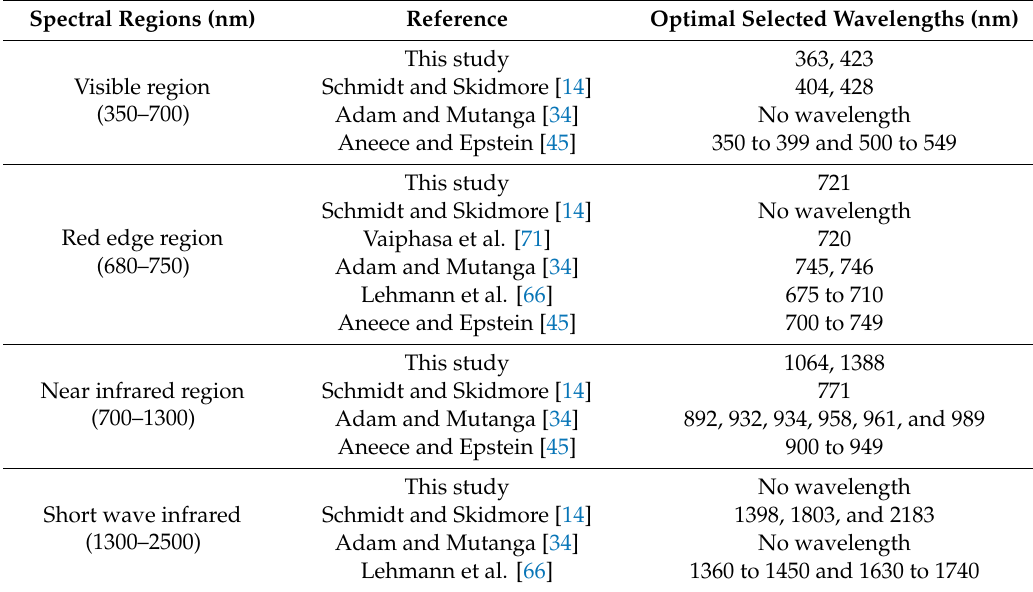
Table 3. The frequency of selected spectral wavelengths for the separation of plant species in the four-dimensional range defined by Kumar et al.